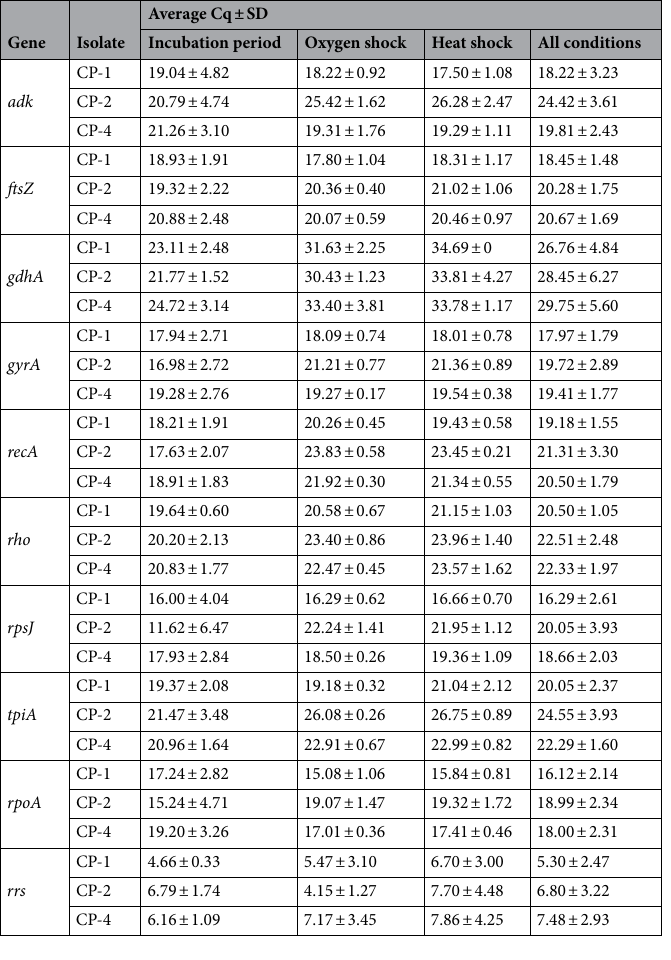
Table 3. Cycle variation across all samples for each growth/stress